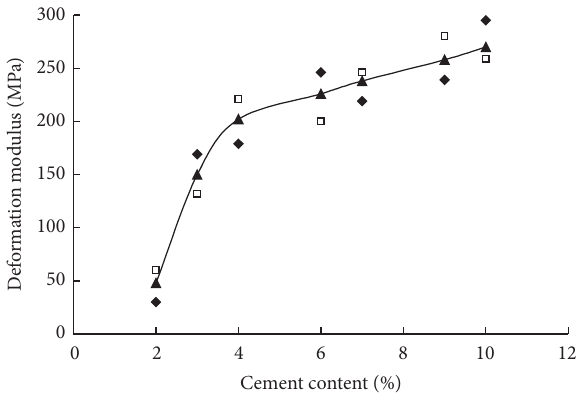
Figure 13: Variation of deformation modulus for different cement